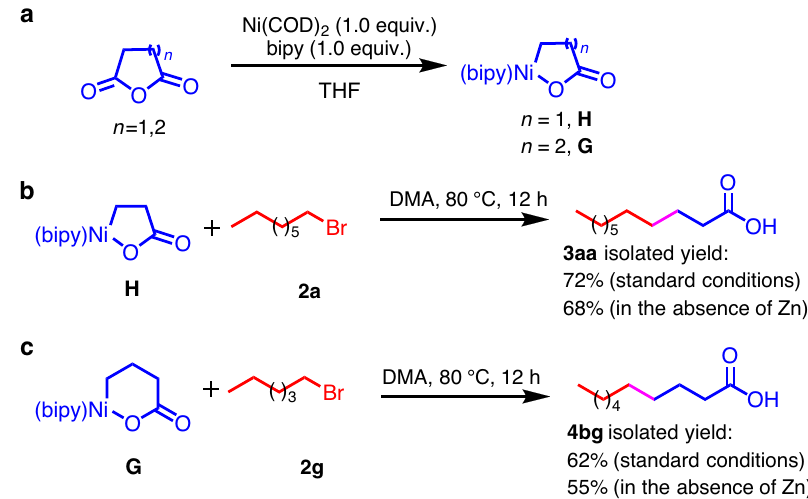
Fig. 4 Preliminary mechanistic studies. a Preparation of Ni-homoenolate and its higher homolog. b Alkylation of the independently synthesized homoenolate H . c Alkylation of the independently synthesized G with alkyl